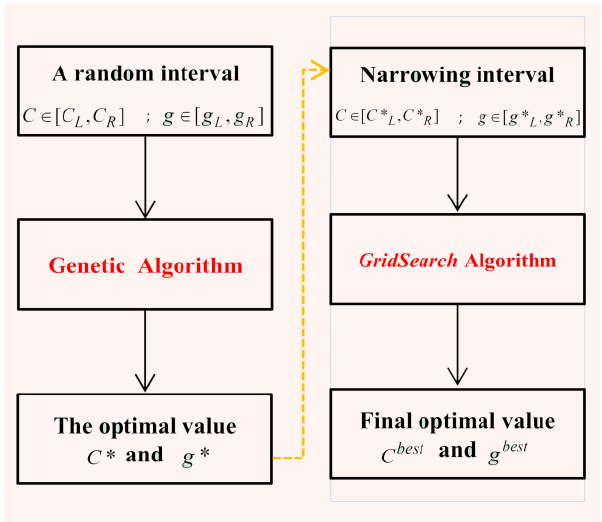
Figure 6. Outline of the proposed GA_SVM parameter tuning strategy.